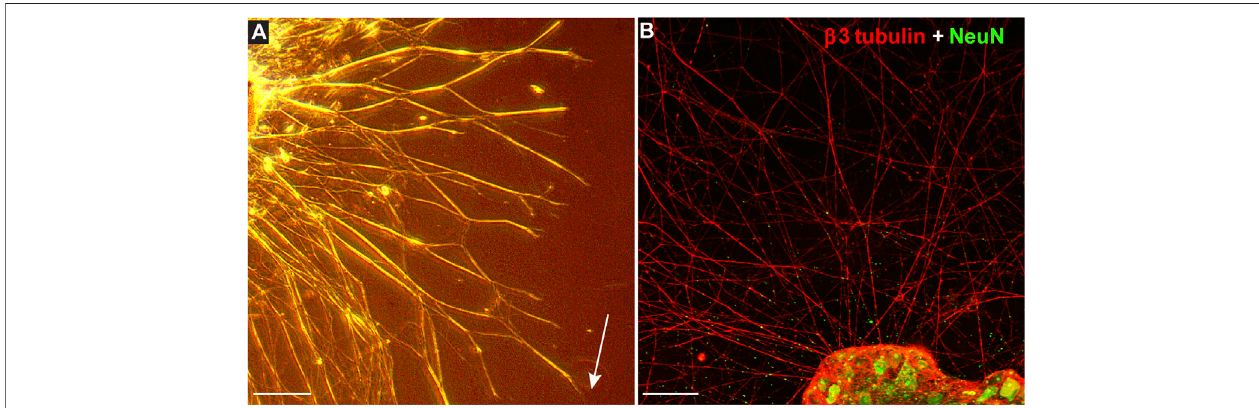
FIGURE 3 | Measuring Explant Outgrowth. (A) DRG explant 48 h after plating on intact collagen visualized live through multi-focal high-magni fi cation phase contrastmicroscopytooptimizeidenti fi cationandmeasurementoflongestneurite(arrow).Confocalmicrographofsimilarexplant (B) showsneuritesimmune-labeledfor β 3-tubulin (red) extending from DRG neurons labeled against NeuN (green). Scale (cid:1) 250 (A) or 100 (B) µm.